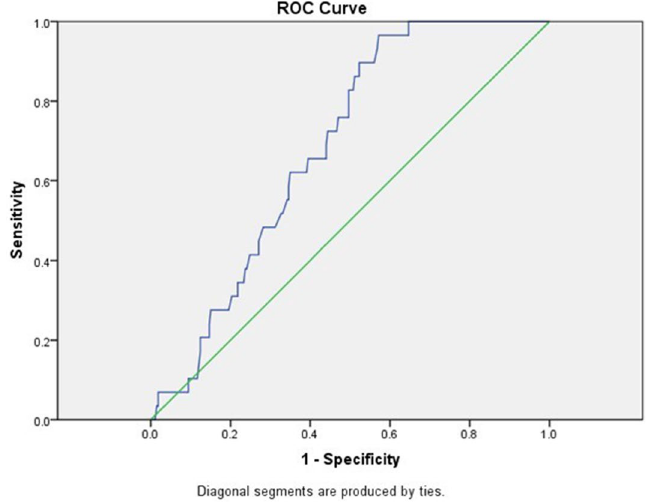
Figure 7. Receiver operator characteristic curve (ROC) of the relation between aortic angle and TOF-PA. A cut-off value of aortic angle ≥ 58.4° yielded a sensitivity of 66% and specificity of